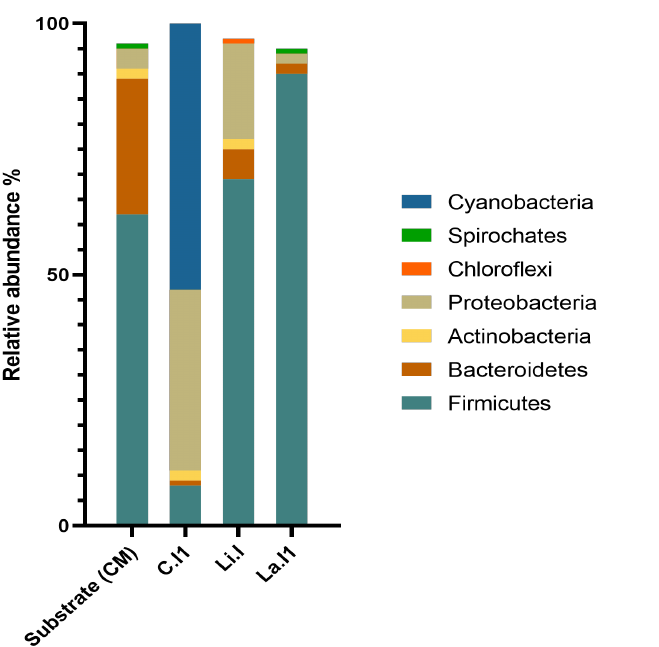
Figure 4. Phylum distribution of prokaryotic 16S rDNA gene sequences in various inocula .